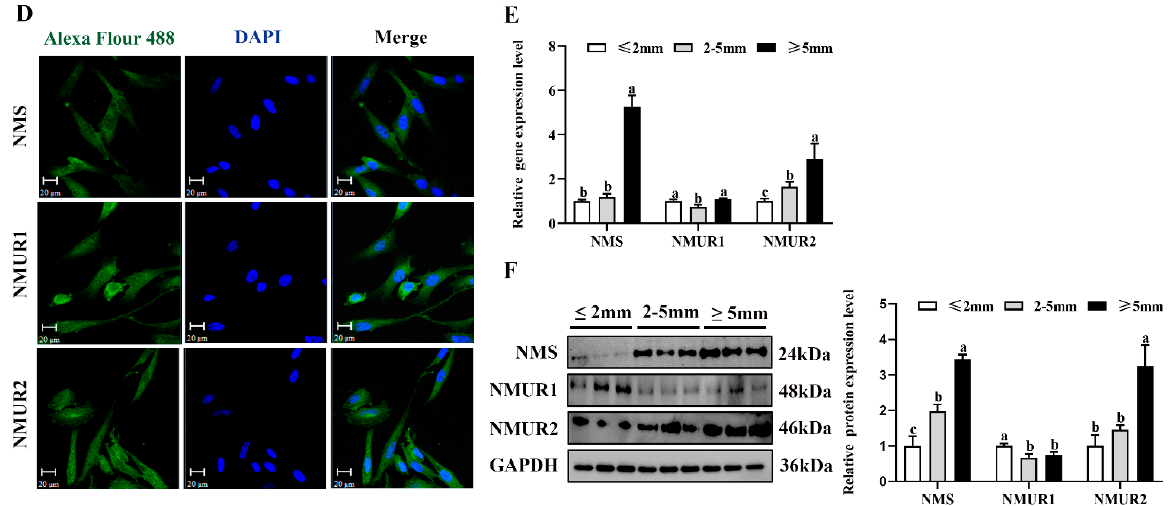
Figure 2. Localization and expression of NMS and its receptor in goat ovaries. ( A ) The mRNA expression of NMS and its receptor in three-month-old and nine-month-old goat ovaries were detected by qPCR. ( B ) The protein expression of NMS and its receptor in three-month-old and nine-month-old goat ovaries were detected by Western blot. ( C ) Localization of NMS and its receptor proteins in goat ovaries. Tissue sections were stained with specific antibodies and counterstained with hematoxylin. Positive signals appeared brown, and counterstaining background appeared blue. a–a4: stained with NMS polyclonal antibody; b–b4: stained with NMUR1 polyclonal antibody; c–c4: stained with NMUR2 polyclonal antibody; d–d4: negative control (no significant immunoreactivity was observed with normal fetal bovine serum instead of the primary antibody); EN: oocyte nest; PM: primordial follicle; PR: primary follicle; SC: secondary follicle; TR: tertiary follicle; scale bar 50 μ m. ( D ) Localization of NMS and its receptor in cultured goat GCs. Blue color: DAPI-stained nuclei; red color: immunofluorescence representing the reaction of antibodies with antigens. ( E ) The mRNA expression of NMS and its receptor in different diameters of follicles were detected by qPCR. (F) The protein expression of NMS and its receptor in different diameters of follicles were detected by Western blot; data are expressed as fold change and are presented as mean ± S.E.M. of the results obtained in at least three independent experiments. Different letters indicate significant differences in the expressions between the groups ( p < 0.05).